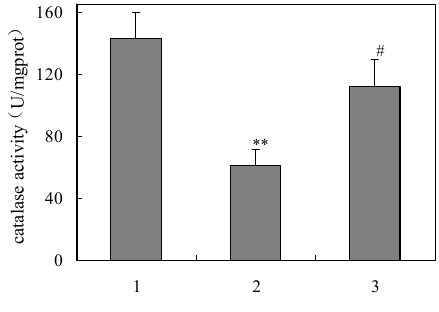
Figure 6. Effect of 5'-adenylic acid on catalase activity of liver in mice after γ -ray irradiation. ( 1 ) Normal group; ( 2 ) Model group; and ( 3 ) 5'-AMP-treated group. ** p < 0.01 vs. Normal; # p < 0.05 vs.